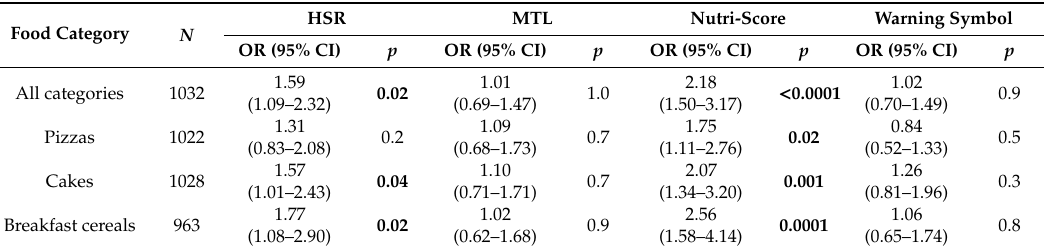
Table 3. Associations between FoPLs and change in ability to correctly rank products between no label and labeling